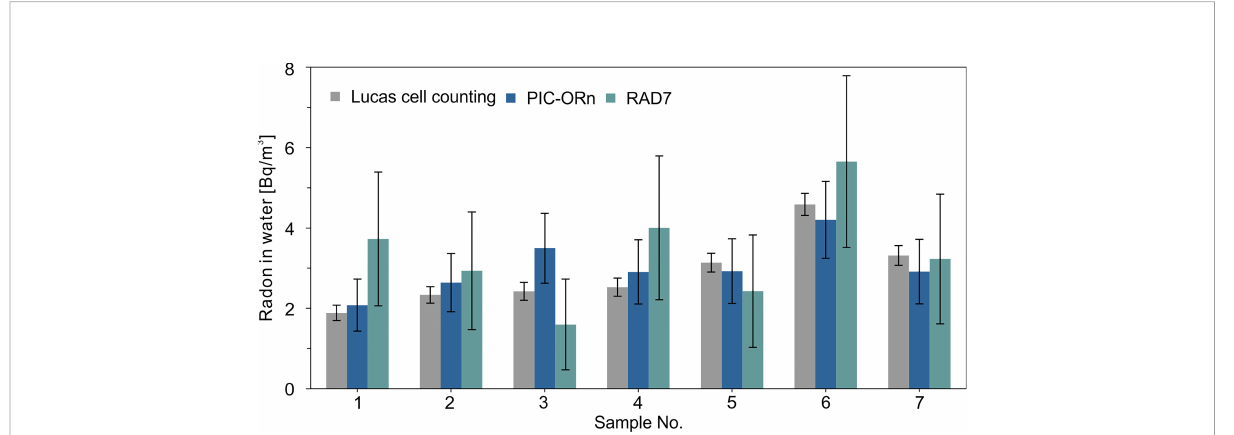
FIGURE 7 Seven surface seawater samples were collected during the boat survey (the locations of the sampling points are shown on Figure 6). Bar diagram shows the radon in surface water results from a comparison between three independent techniques: a radon-gas extraction line combined with Lucas cell counting (grey), the PIC-ORn detection system (blue) and the RAD7 systems (green). The error bars represent the 1- s uncertainties based on counting statistics.